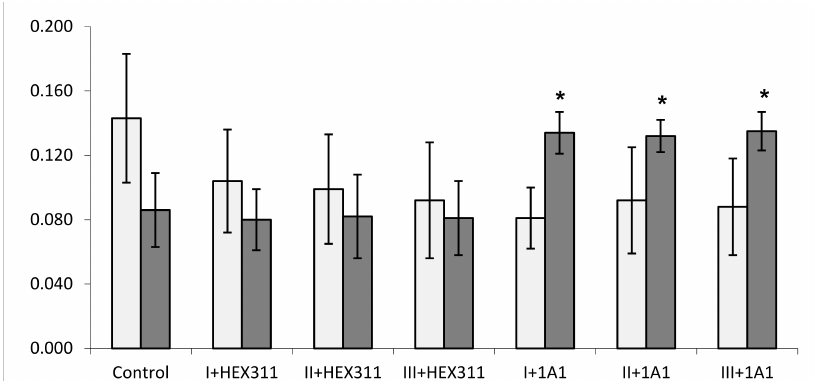
Figure 1. Evolution of Endozoicomonas sp. Hex311 (HEX311) and Pseudoalteromonas sp. 1A1 (1A1) co-cultivated in presence of three batches (I, II, and III) of Suberites domuncula primmorphs during 16